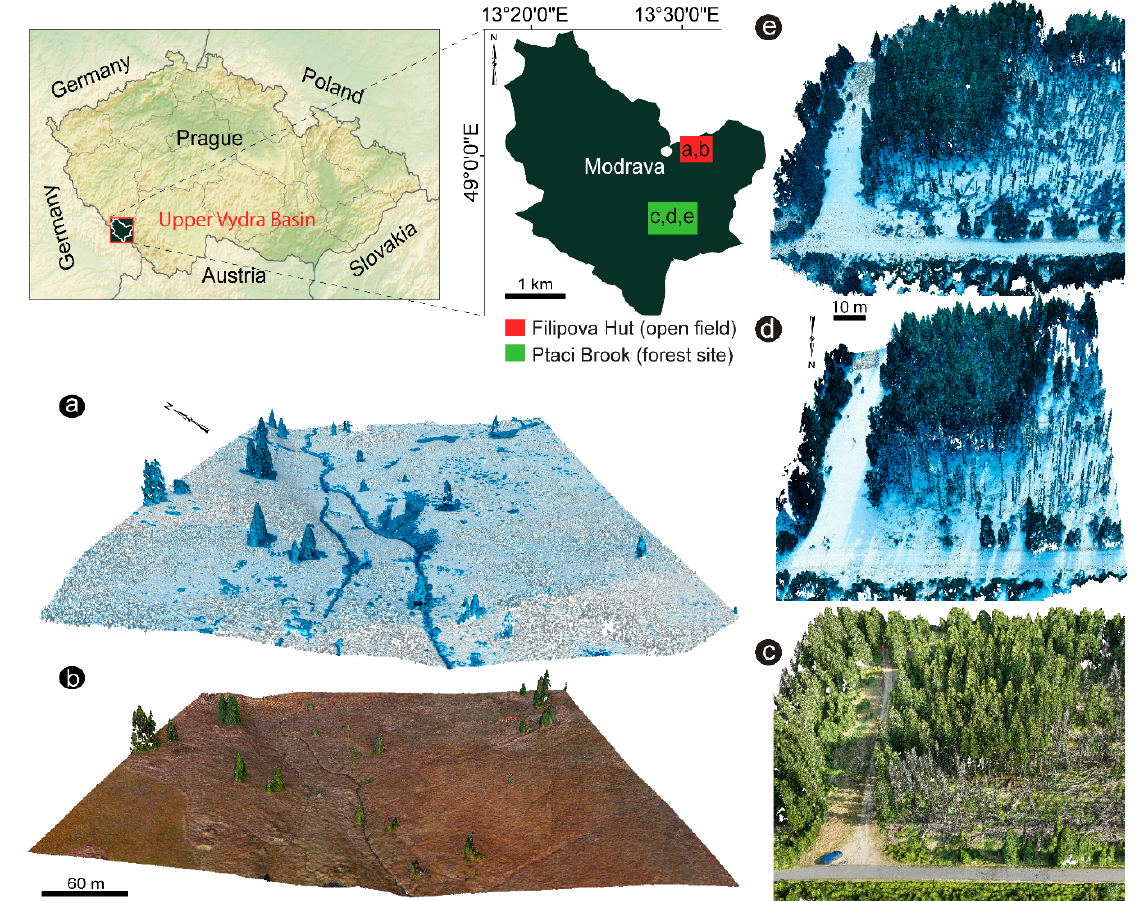
Figure 1. An overview map of the study area ( a ). Location of the regions surveyed with the generated 3D point cloud models. These point clouds assist in providing visual information on the snow surface and terrain type. The red box shows the open area (Filipova Hut) during snow ablation ( a ) and snow-free period ( b ), the green box displays the disturbed spruce forest zone (Ptaci Brook) during snow-free period ( c ) snow-covered (e.g., peak accumulation) ( d ), and snow ablation period ( e )).